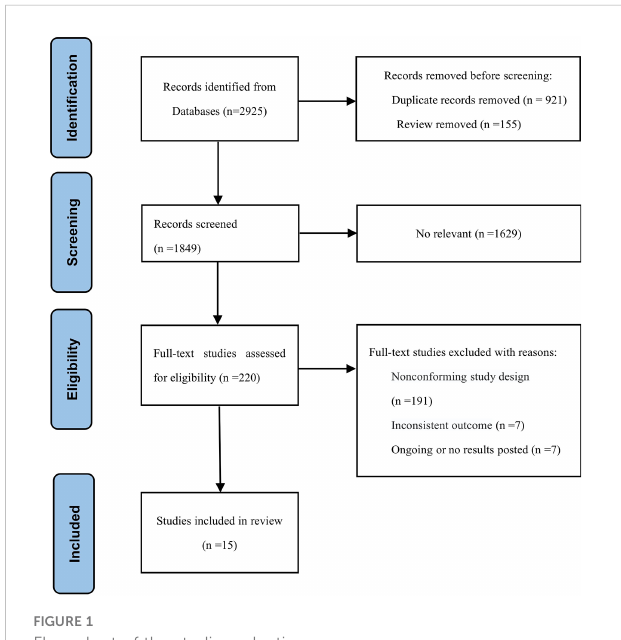
FIGURE 1 Flow chart of the studies selection